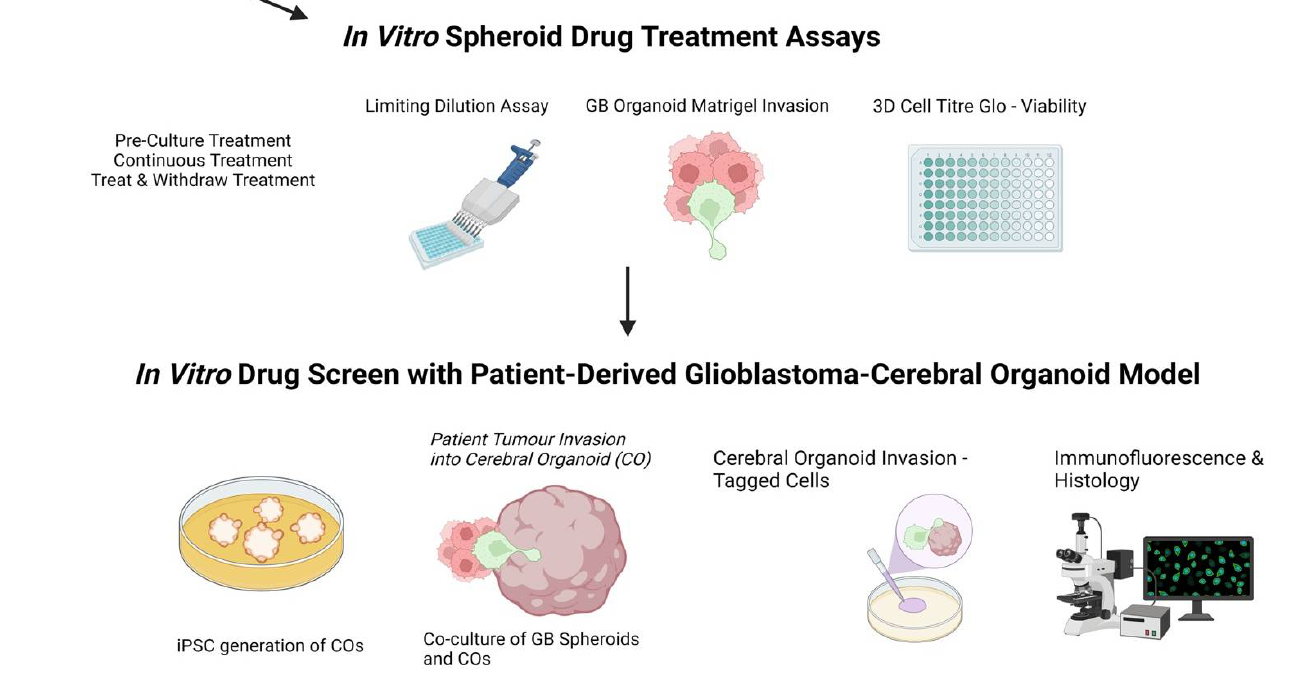
Figure 4. A potential workflow for drug screening using the GLICO model: 1. Generation of spheroid forming primary glioblastoma (GB) cells and biobanking of patient samples. 2. Prospective drug screen on glioblastoma spheroids. 3. Refined drug screen using patient-derived glioblastoma-cerebral organoid (GLICO) model. Created with Biorender.com accessed on 25 September 2022.